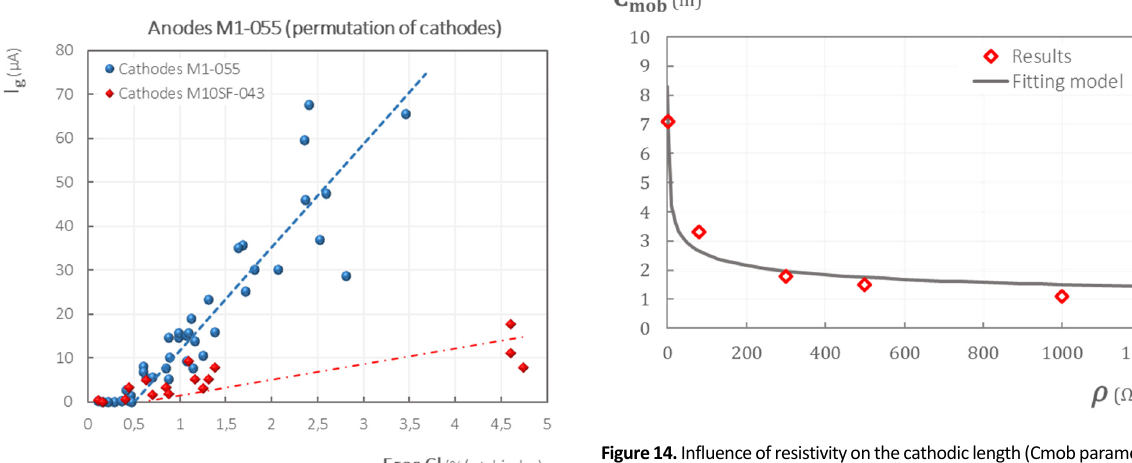
Figure 14. Influence of resistivity on the cathodic length (Cmob parameter (m)) that can be mobilized in a “localized” corrosion process